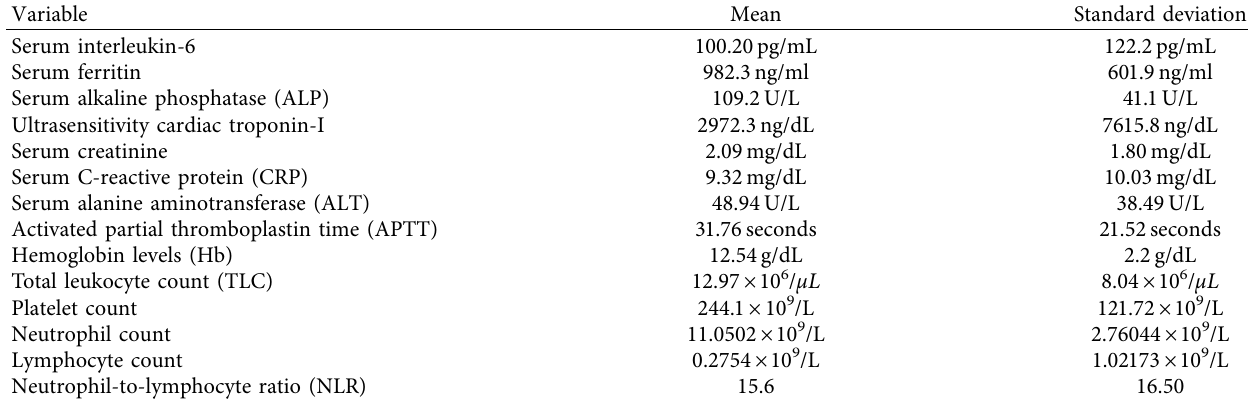
Table 1: Mean value of inflammatory